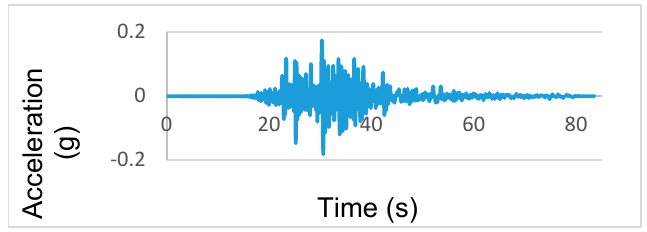
Figure 31. 2011 Van earthquake south–north acceleration–time graph.